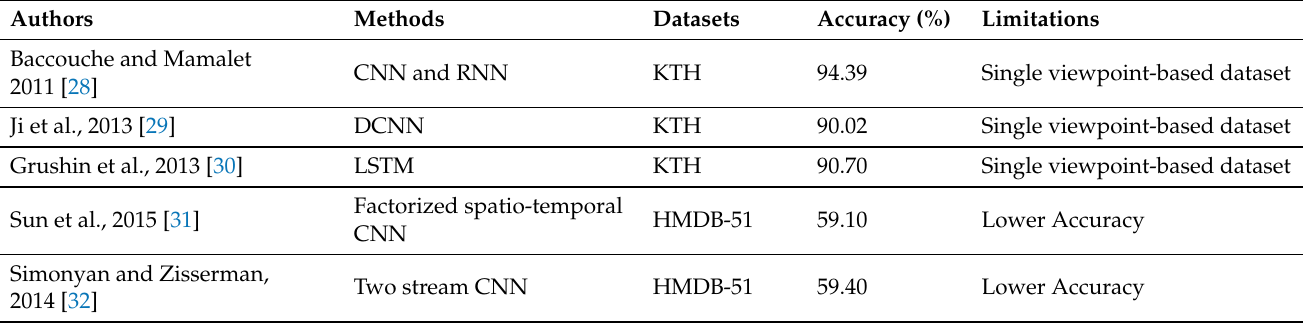
Table 1. Review on techniques for Human Action